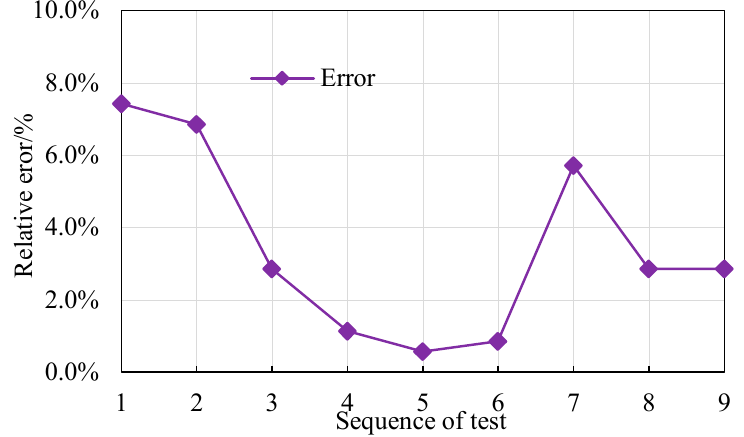
Figure 13. The error between the measured and calculated load resistance values.